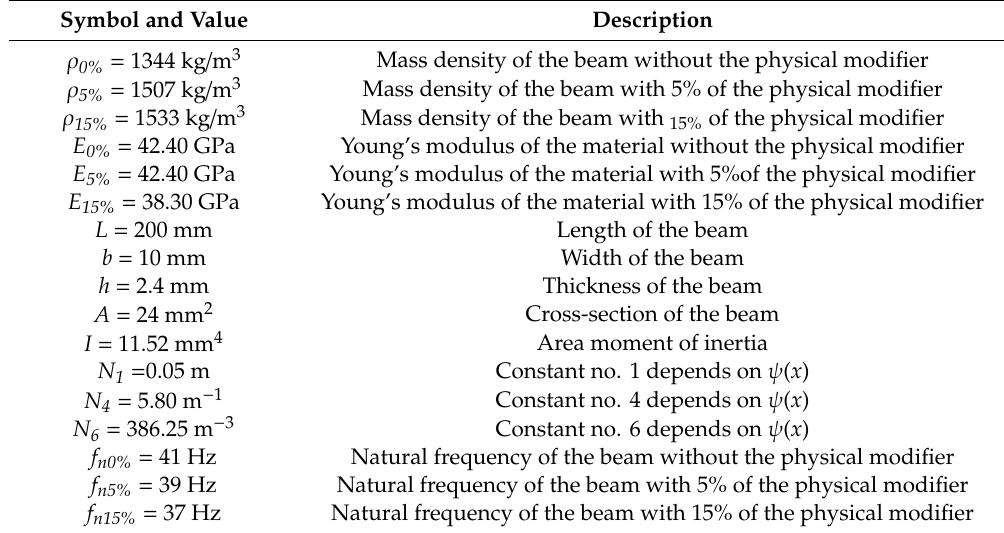
Table 1. The parameters of the composite material